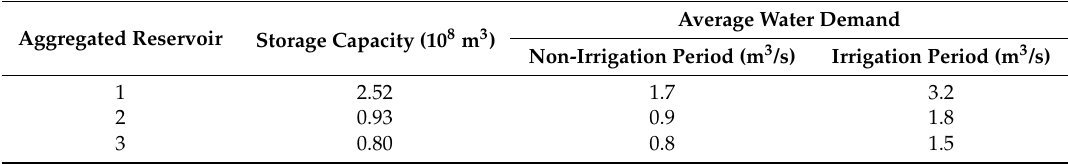
Table 1. Configuration of aggregated